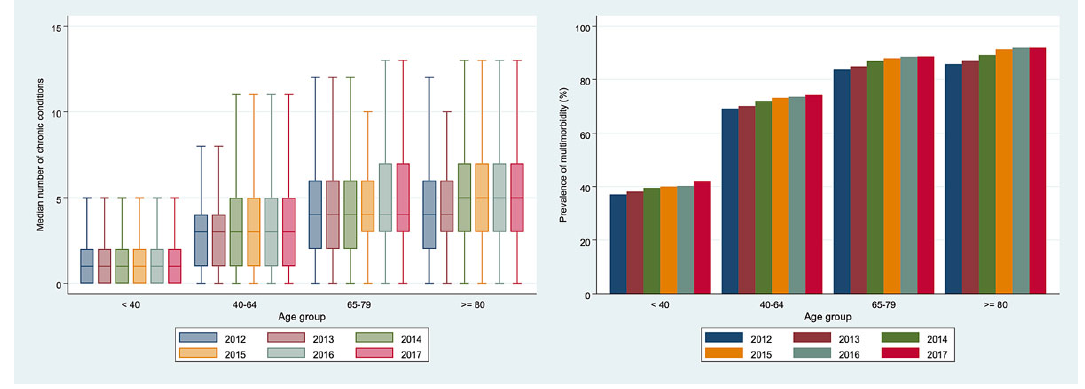
Figure S2: Time-dependent median number of chronic conditions and prevalence of multimorbidity stratified by